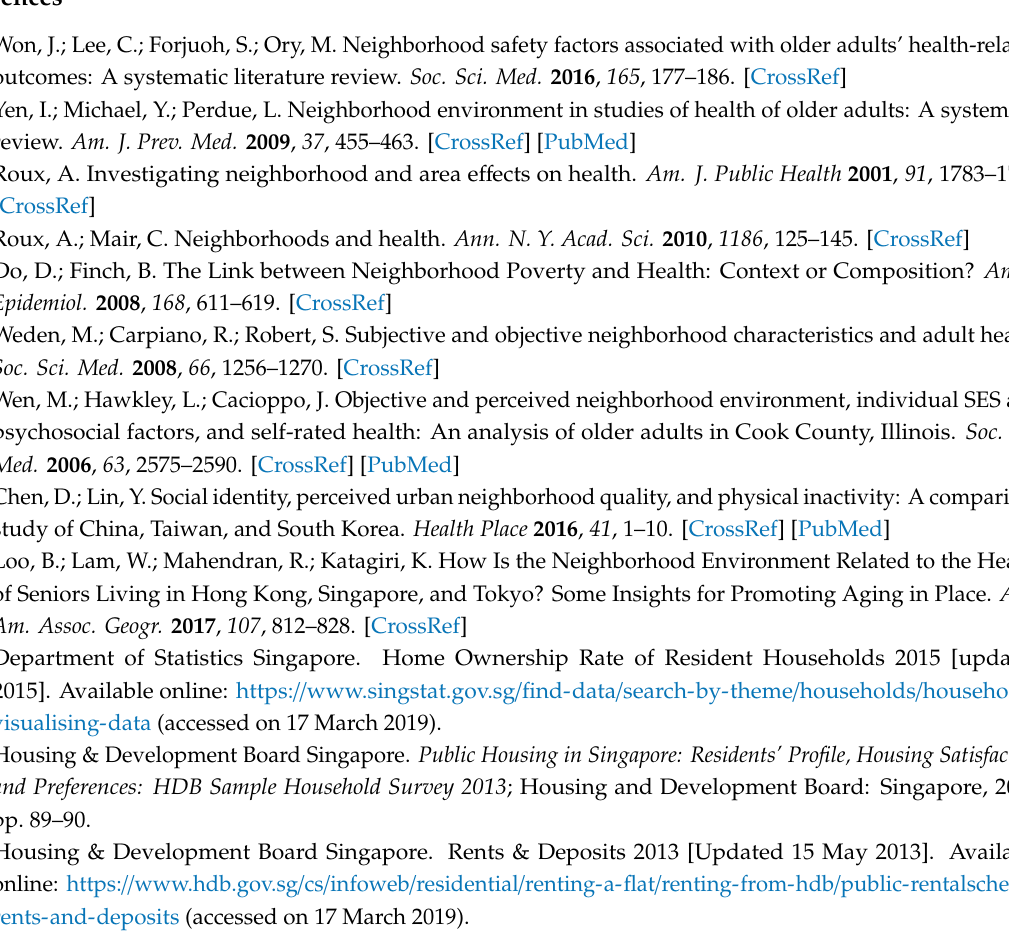
Table S1: Principal components analysis of the modified 17-item Neighborhood Environment Walkability Scale-Abbreviated